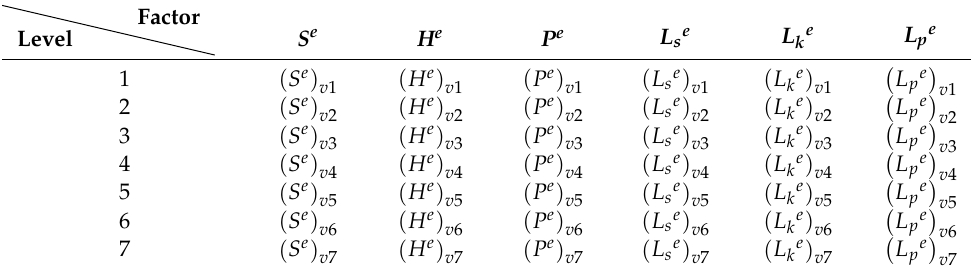
Table 3. Six-factors-seven-levels matrix table of flexible interconnected configuration parameters.